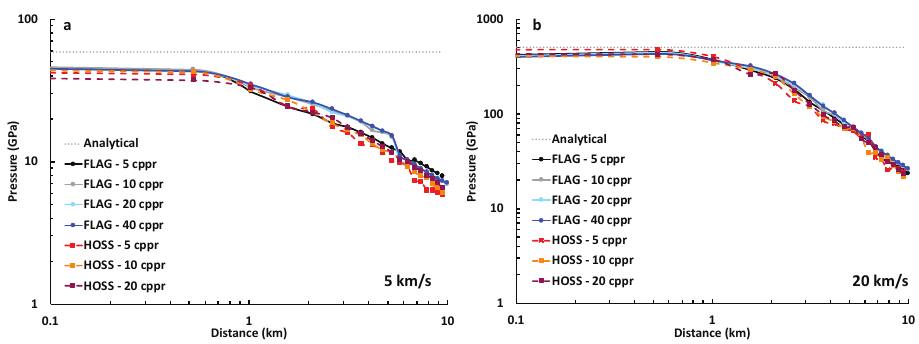
Figure 4. 2D mesh resolution study for FLAG and HOSS for ( a ) 5 km/s normal impact and ( b ) 20 km/s normal